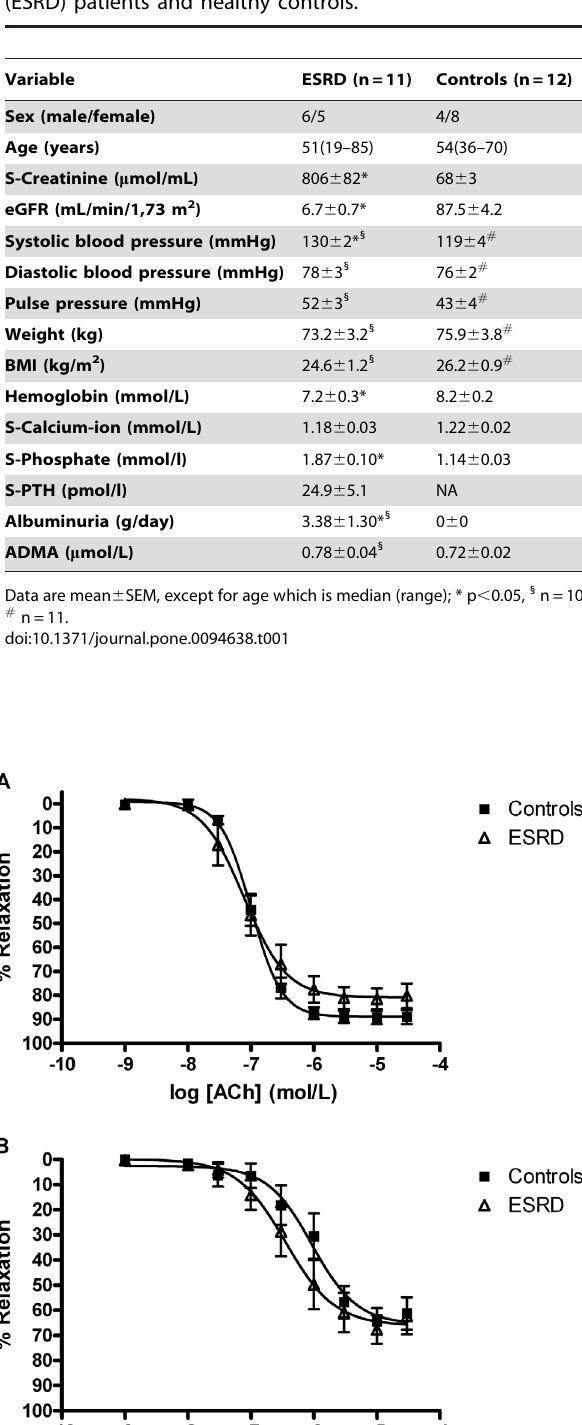
Table 1. Baseline characteristics for end stage renal disease (ESRD) patients and healthy controls.